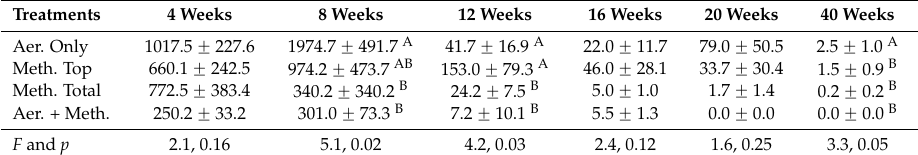
Table 1. Mean numbers ( ˘ SE) of adult T. castaneum captured by probe traps at different times after bins were loaded with wheat that was either treated with aeration only, the top 50 cm-treated with methoprene, methoprene treatment to all the wheat in a bin, or aeration plus complete treatment with methoprene on all grain in the bin. Means within columns with the same upper case letter, for which there was a significant ( p ď 0.05) F-statistic, are not significantly different (least significant difference (LSD) test, p < 0.05, SAS Institute, degrees of freedom for analysis within date for treatment were 3, 12).